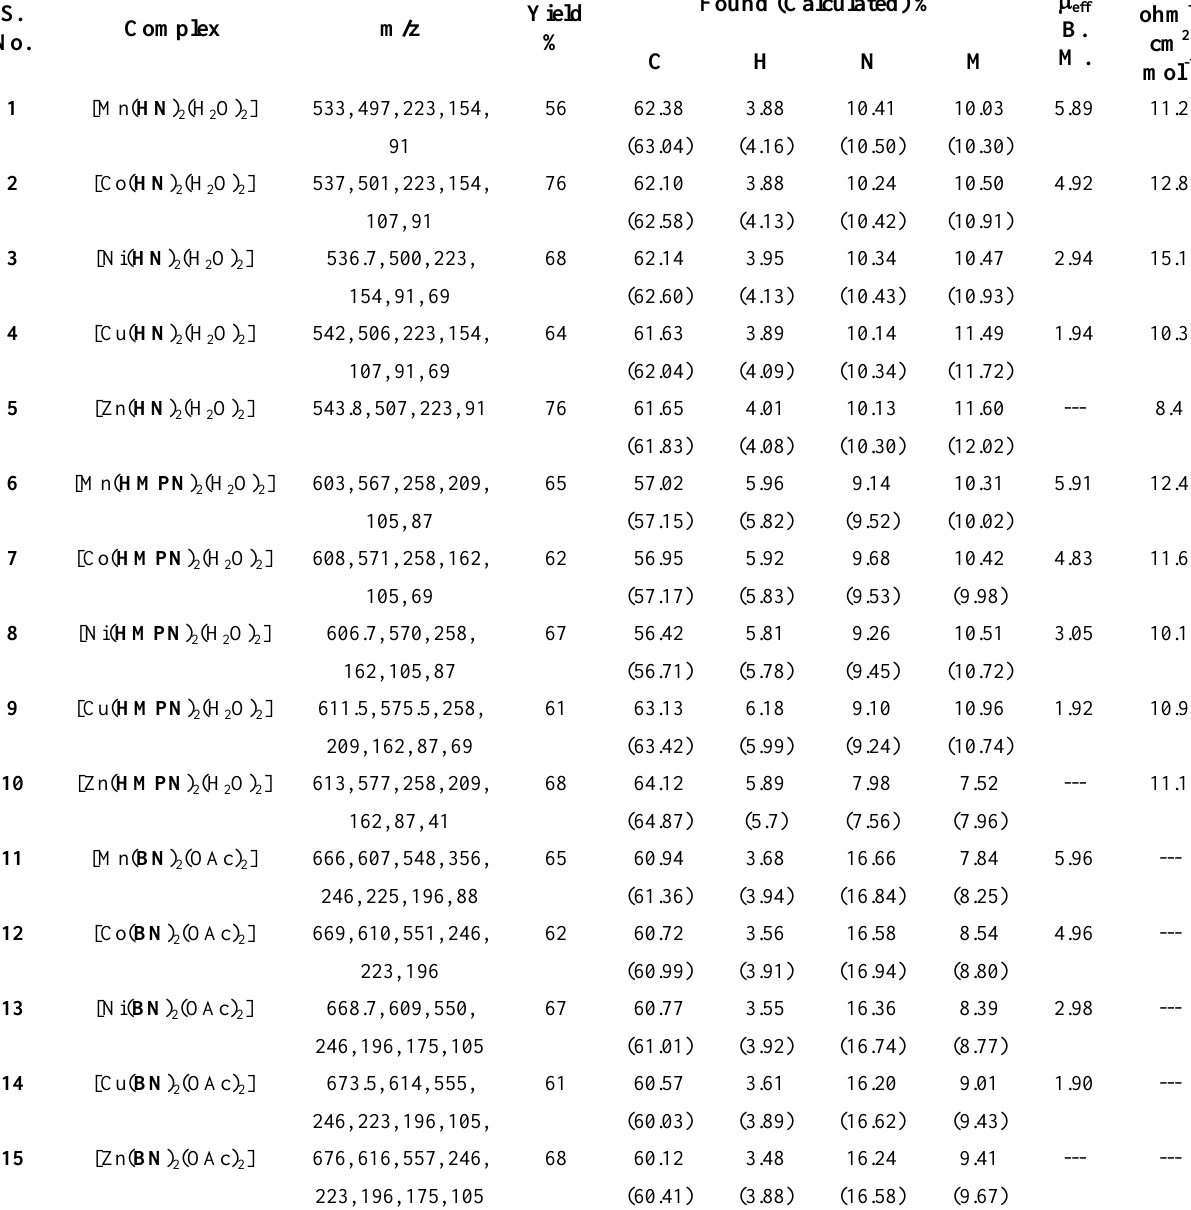
Found (Calculated) %